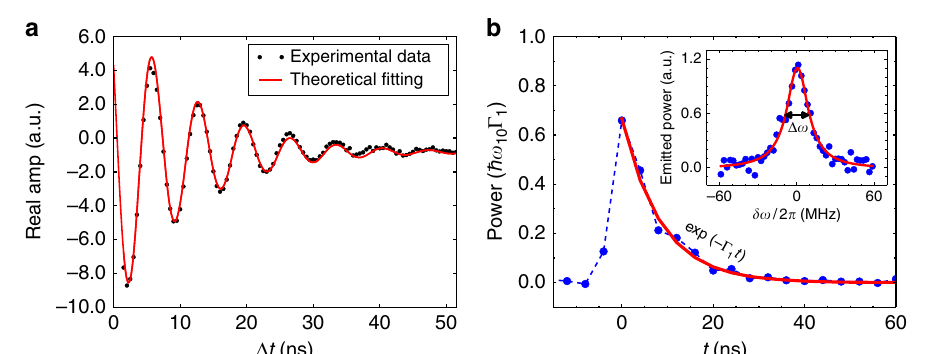
Figure 3 | Device operation. ( a ) Rabi oscillations of the two-level atom coupled to the two half-spaces measured by VNA. The atom is excited by MW pulses of length D t from the control line with repetition time T ¼ 80ns, and the coherent emission is detected from the emission line. ( b ) The emitted photon shape normalized to the single photon power. The red solid curve shows a fit to exp( (cid:2) G 1 t ). The inset demonstrates an emission peak (blue dots), when a p -pulse is applied at D t p fitted by a red Lorentzian curve ( D o ¼ G 1